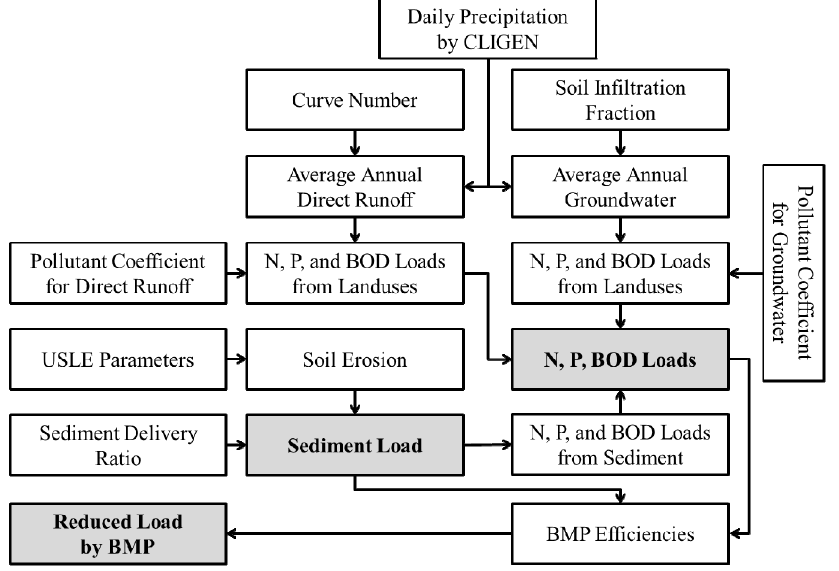
Figure 3. Average annual direct runoff, groundwater and pollutant load computation in STEPL WEB. USLE, Universal Soil Loss Equation; BOD, biological oxygen